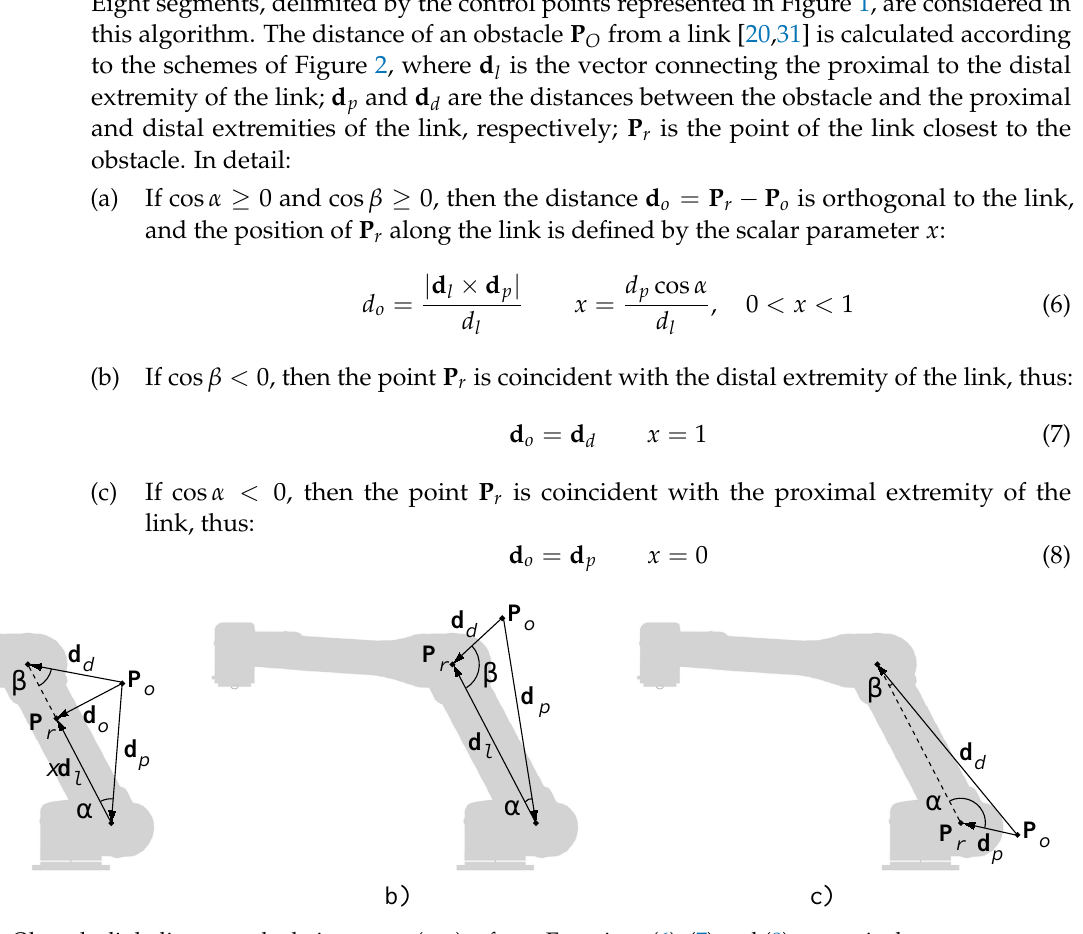
Figure 2. Obstacle–link distance calculation; cases ( a – c ) refer to Equations (6), (7) and (8)